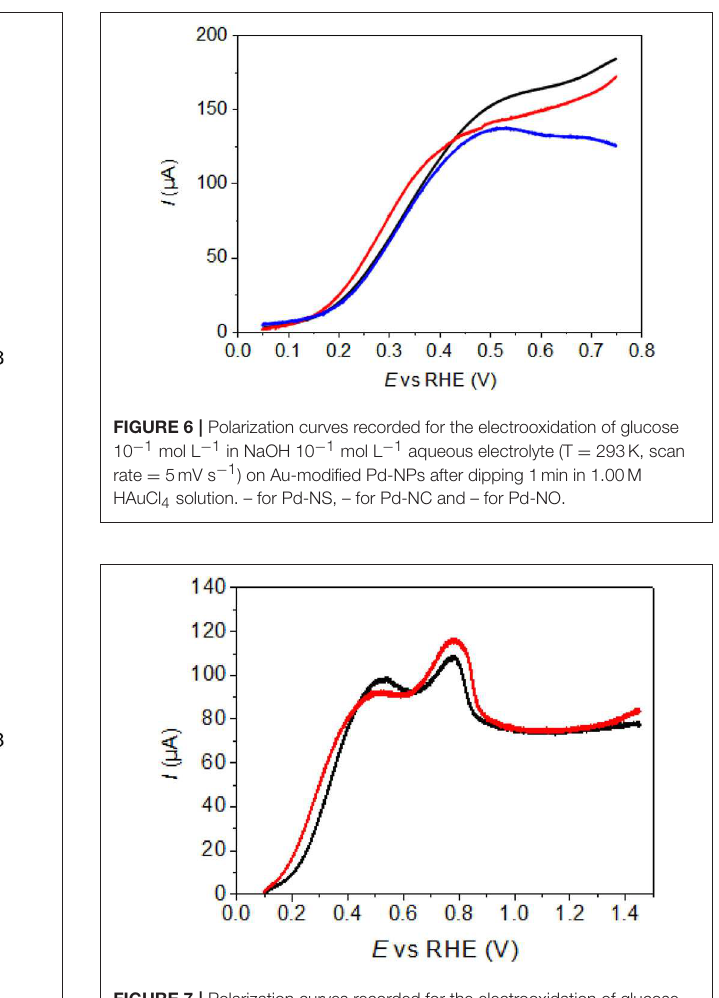
FIGURE 7 | Polarization curves recorded for the electrooxidation of glucose 10 − 1 mol L − 1 in NaOH 10 − 1 mol L − 1 aqueous electrolyte (T = 293K, scan rate = 5mV s − 1 ) on Au-modified Pd-NCs after dipping 1min in 1.00M HAuCl 4 solution. – after cycling up to 1.45V vs. RHE in 0.5M H 2 SO 4 electrolyte and – without preliminary cycle (pristine